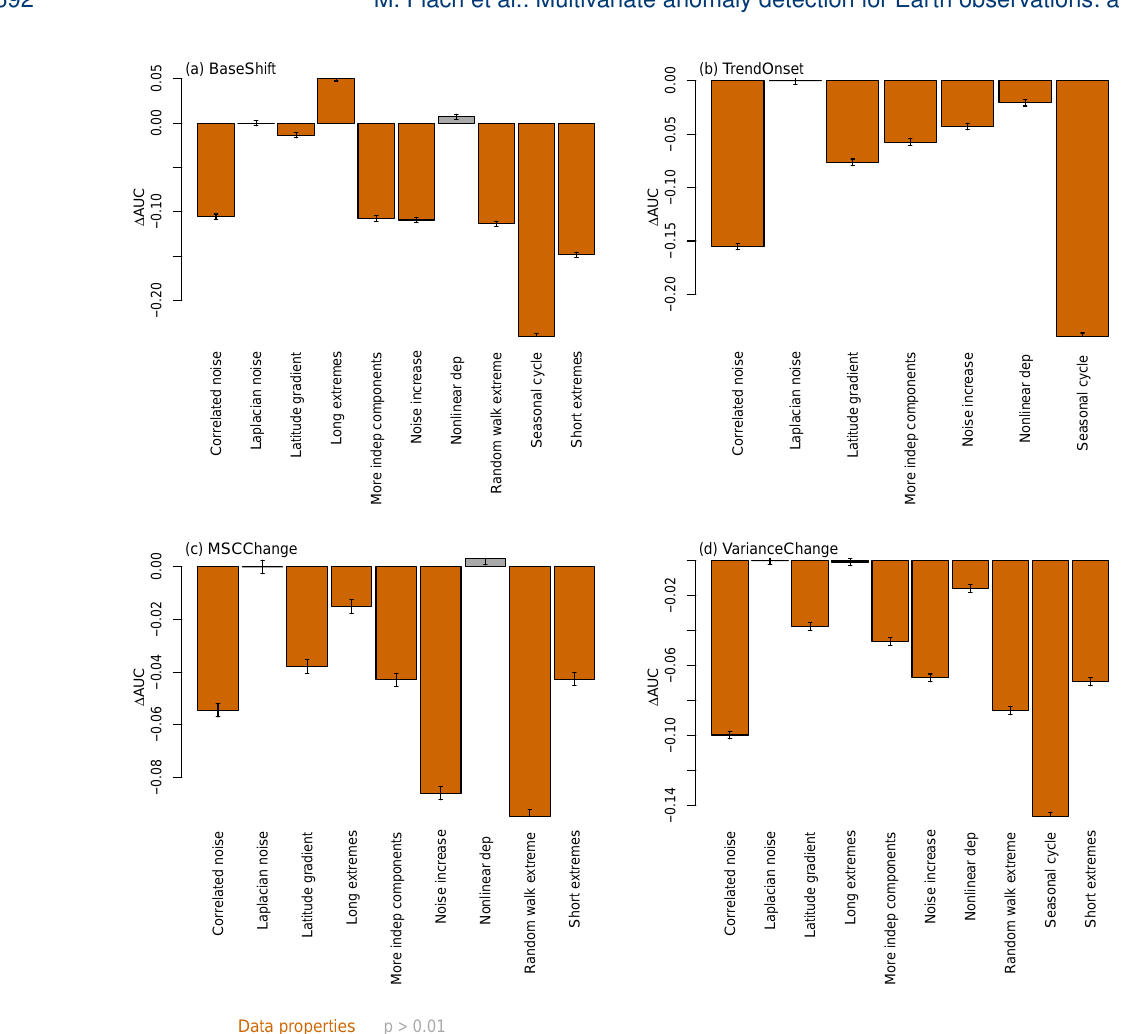
Figure B2. Effect of the data properties on the three best detection algorithms (KDE, REC, KNN-Gamma) presented as AUC difference of the UNIV control for the event types (a–d)